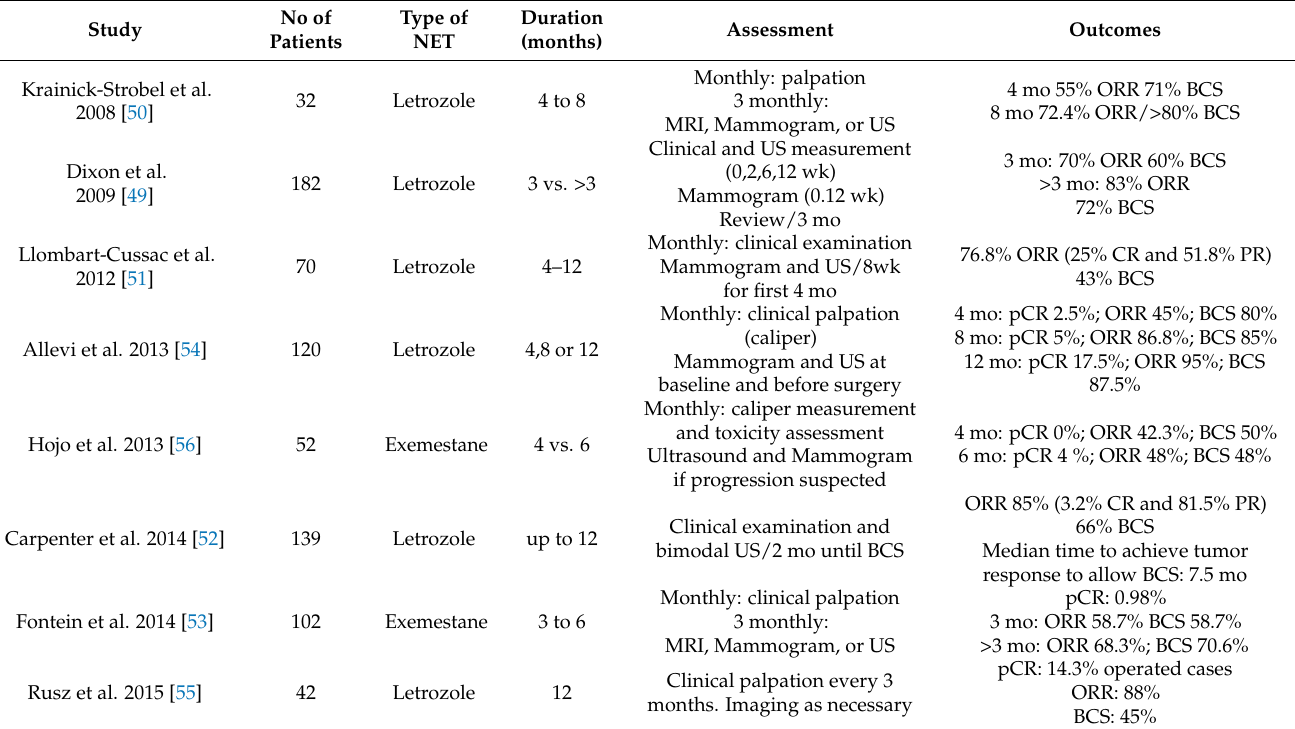
Table 3. Duration of